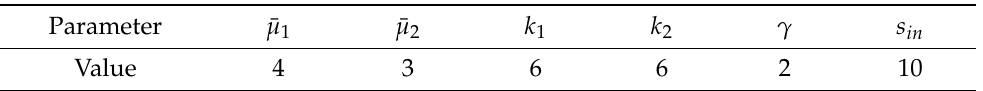
Table 1. The chosen parameters in the numerical simulations are used to just illustrate the results, and they have no practical biological